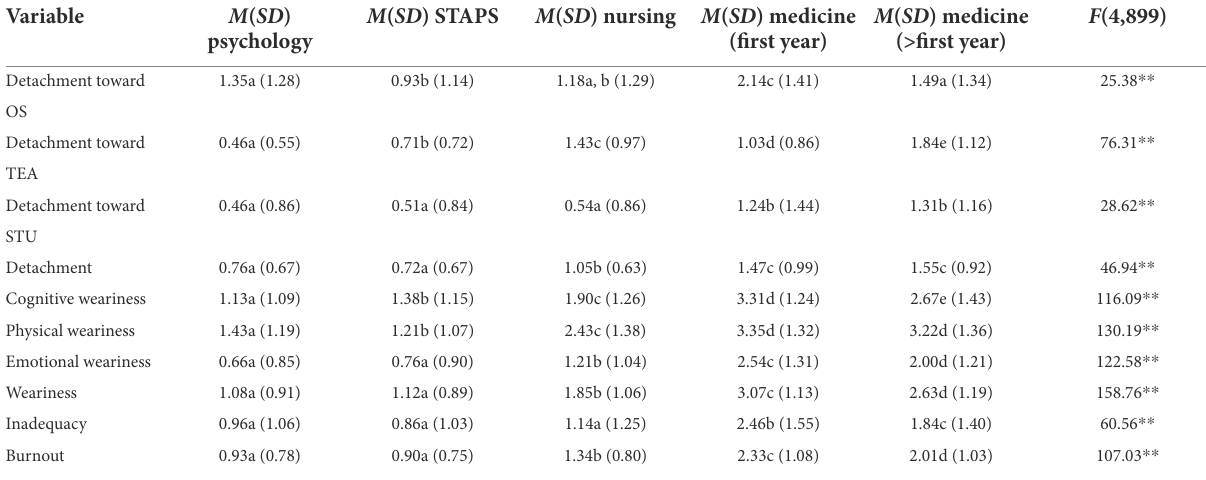
TABLE 3 Comparison of burnout levels and burnout symptoms levels of students who come from several disciplinary (LSD test).